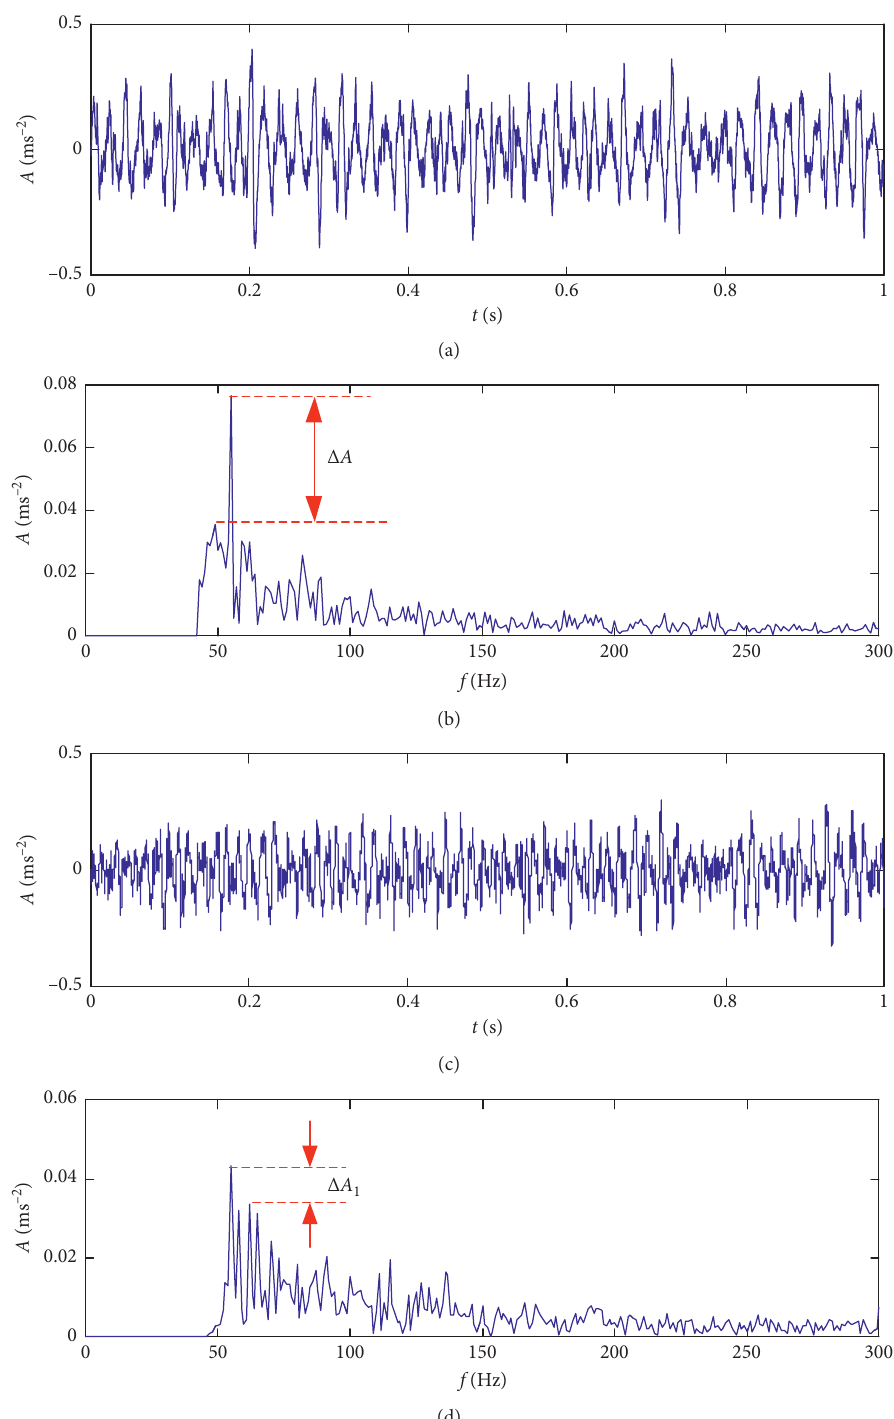
Figure 6: The results of the TFMSR method: (a) time domain waveform of the simulated signal; (b) spectrum. The results of the CBSR method: (c) time domain waveform of the simulated signal; (d)